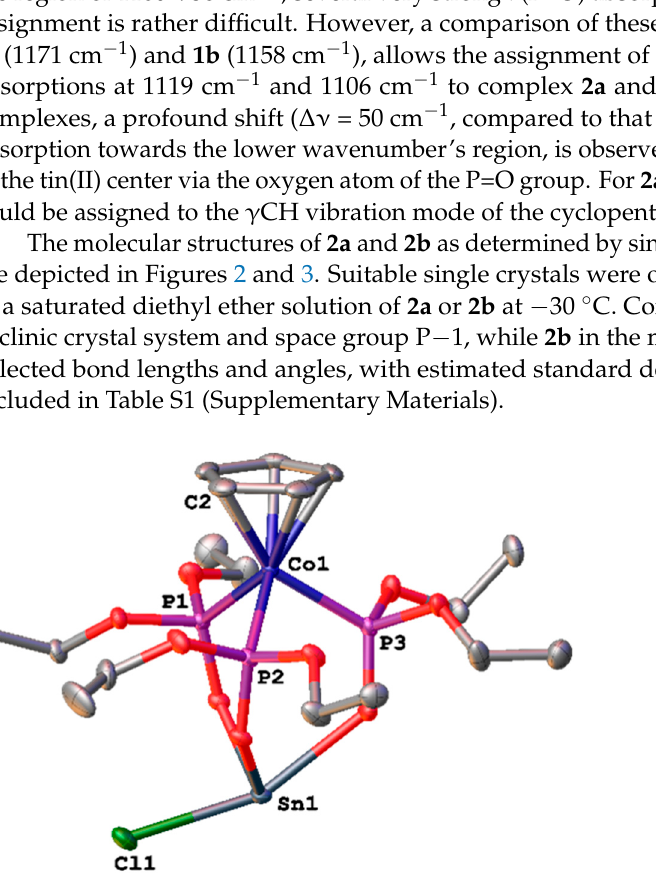
Figure 2. The molecular structure of 2a in the solid state. Thermal ellipsoids are set at 50% probability. Hydrogen atoms are omitted for clarity. Two crystallographically independent molecules are found in the crystal structure; the listed bond lengths and angles are the average values for the two molecules.